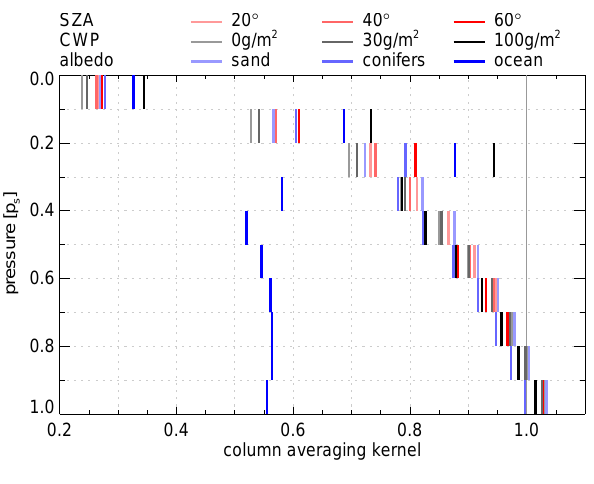
Fig. 9. Column averaging kernels of nine scenarios differing by the solar zenith angles, albedo, and cloud water/ice path. All nine scenarios are based on the “dry run”